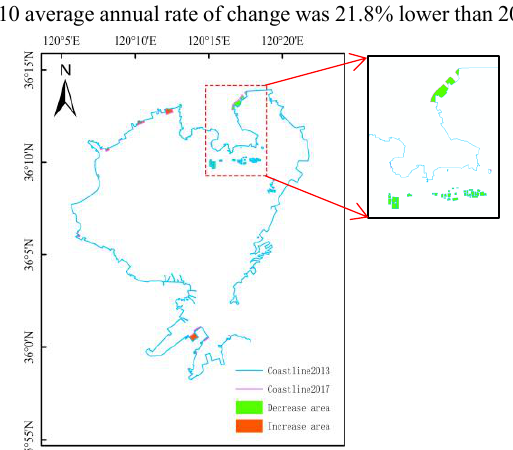
Figure 6 Increase and Decrease in Jiaozhou Bay 2013-2017 2007, and 2010-2011 average annual rate of more than 2007- 2010 was up 77.1%, especially the average annual rate of change in 2012-2013 has increased by 137.1% compared with 2011- 2012. Since 2013, although the average annual change rate of 2015-2016 has been greatly changed than that of 2014-2015 years, the area of increase is small and the total amount of change is not